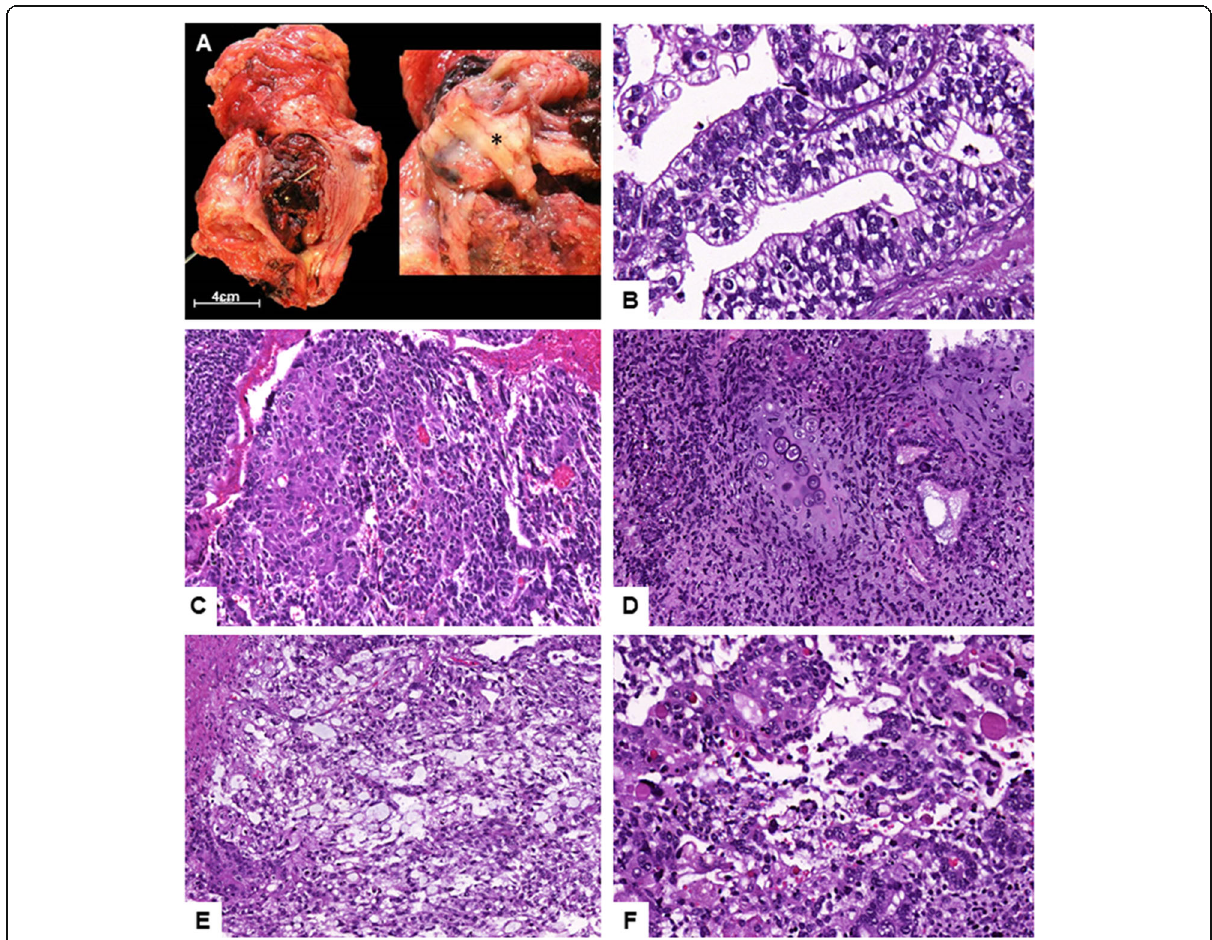
Fig. 2 Surgical specimen of cystectomy showing a macroscopically heterogeneous tumor. Solid areas are marked with*( a ). Microscopically the tumor exhibited an area of glandular pattern with supra and infranuclear vacuoles ( b ). Area with hepatoid pattern ( c ). Area with an undifferentiated sarcomatoid component and focus of chondroid differentiation (HE) ( d ). Areas with reticular-microcystic pattern exhibiting hyaline globules (HE) ( e-f